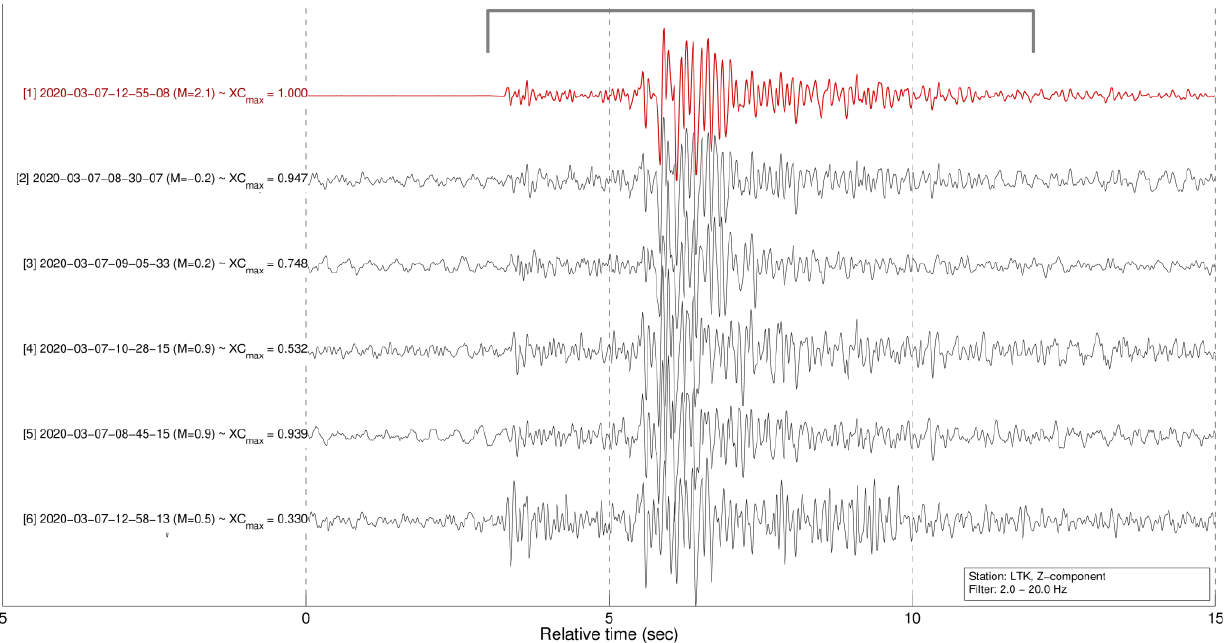
Figure A4. Waveforms of template “2020-03-07-12-55-08” (top, red) and five associated detections (black), belonging to multiplet #114 of CAT2, formed with farthest-neighbor linkage at a threshold of 0.90. The recordings are from the vertical component of station LTK, filtered between 2 and 20 Hz. Specifically, the template is the only aftershock of the M w = 3.9 event E 1 in CAT1.